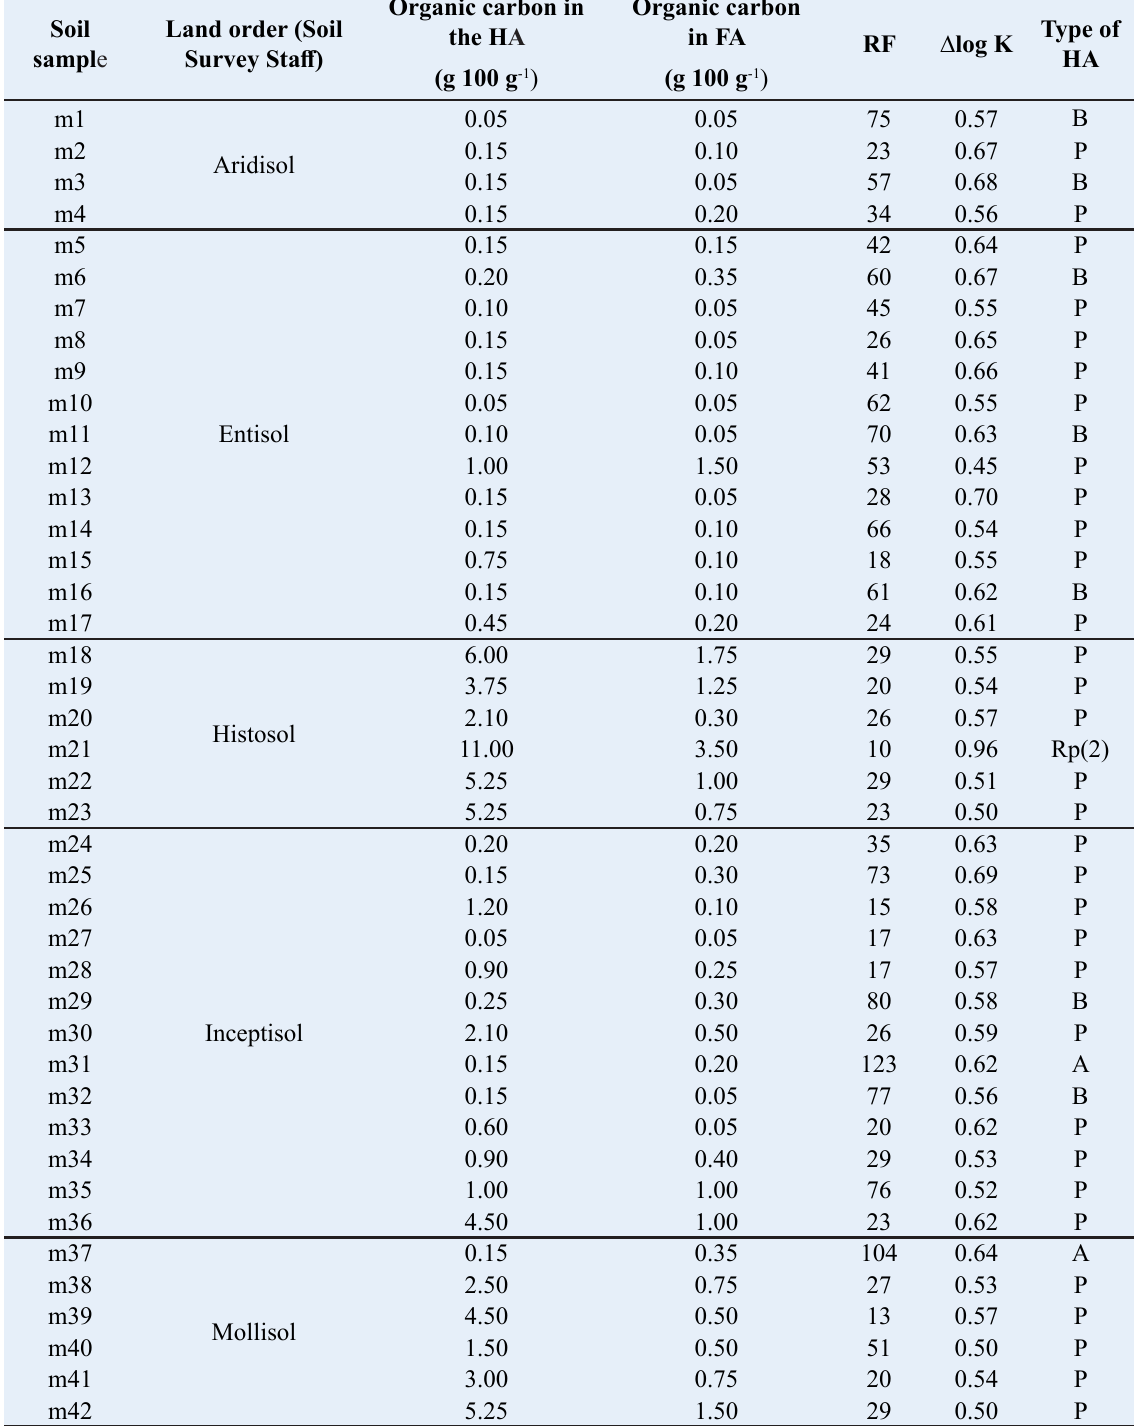
Table 2: Organic carbon content from humic and fulvic acids, and the degree of humification in different soil orders. Soil sampl